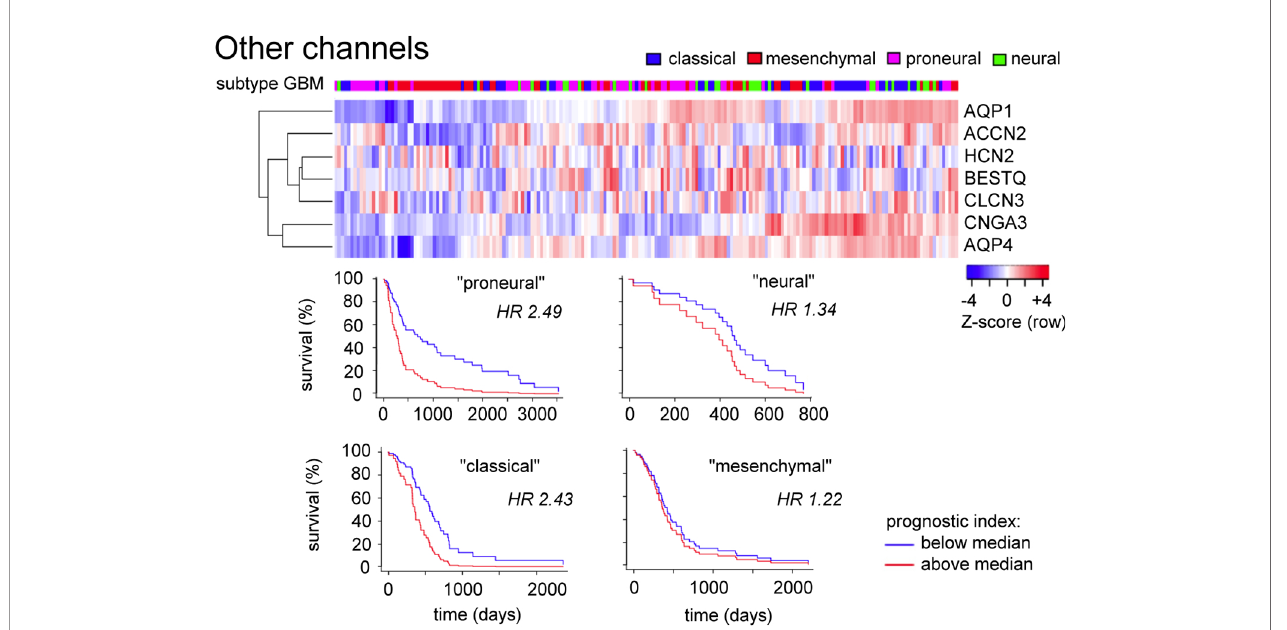
FIGURE 5 | Evaluation of expression patterns for additional classes of channels enriched in glioblastoma. Data were analyzed using the GBM Bio Discovery Portal. GBM, glioblastoma